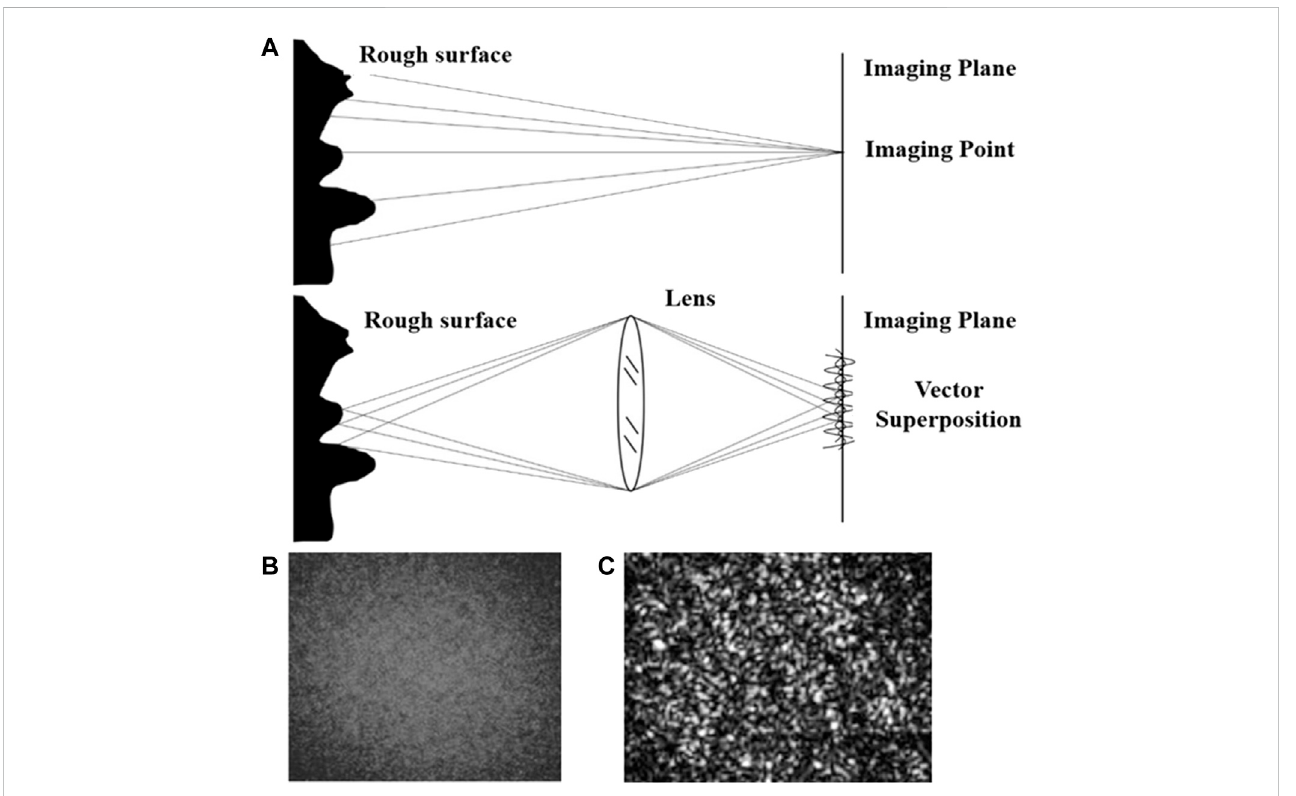
FIGURE 1 Principle of speckle imaging (A) Theoretical schematic diagram of the speckle imaging; (B) Original speckle imaging; (C) Speckle imaging in grayscale, range [0,